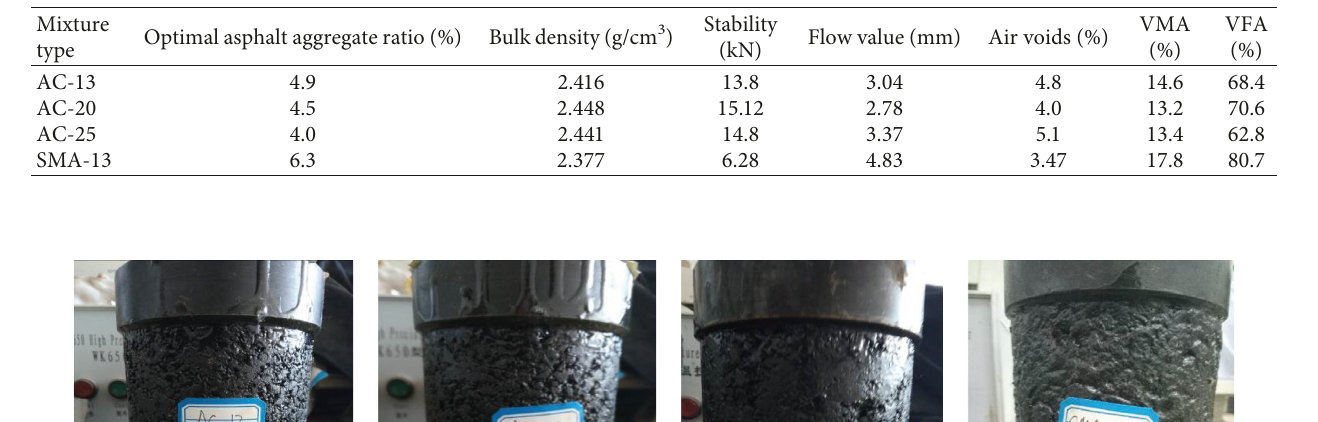
Figure 7: Gradations of four types of asphalt mixture. (a) AC-13, (b) AC-20, (c) AC-25, and (d) SMA-13. Table 1: Summary of volumetric parameters of asphalt mixtures.